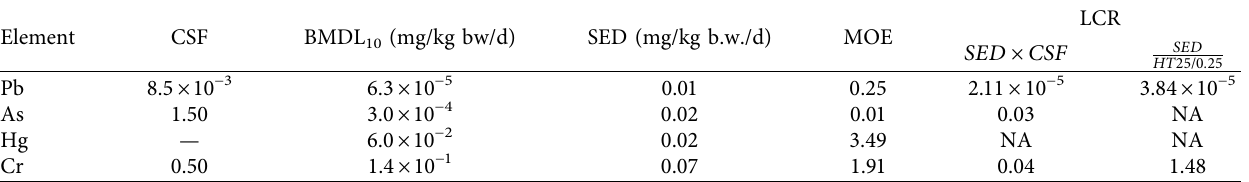
Table 4: Estimated cancer risk assessment of Pb, As, Hg, and Cr in facial makeup.